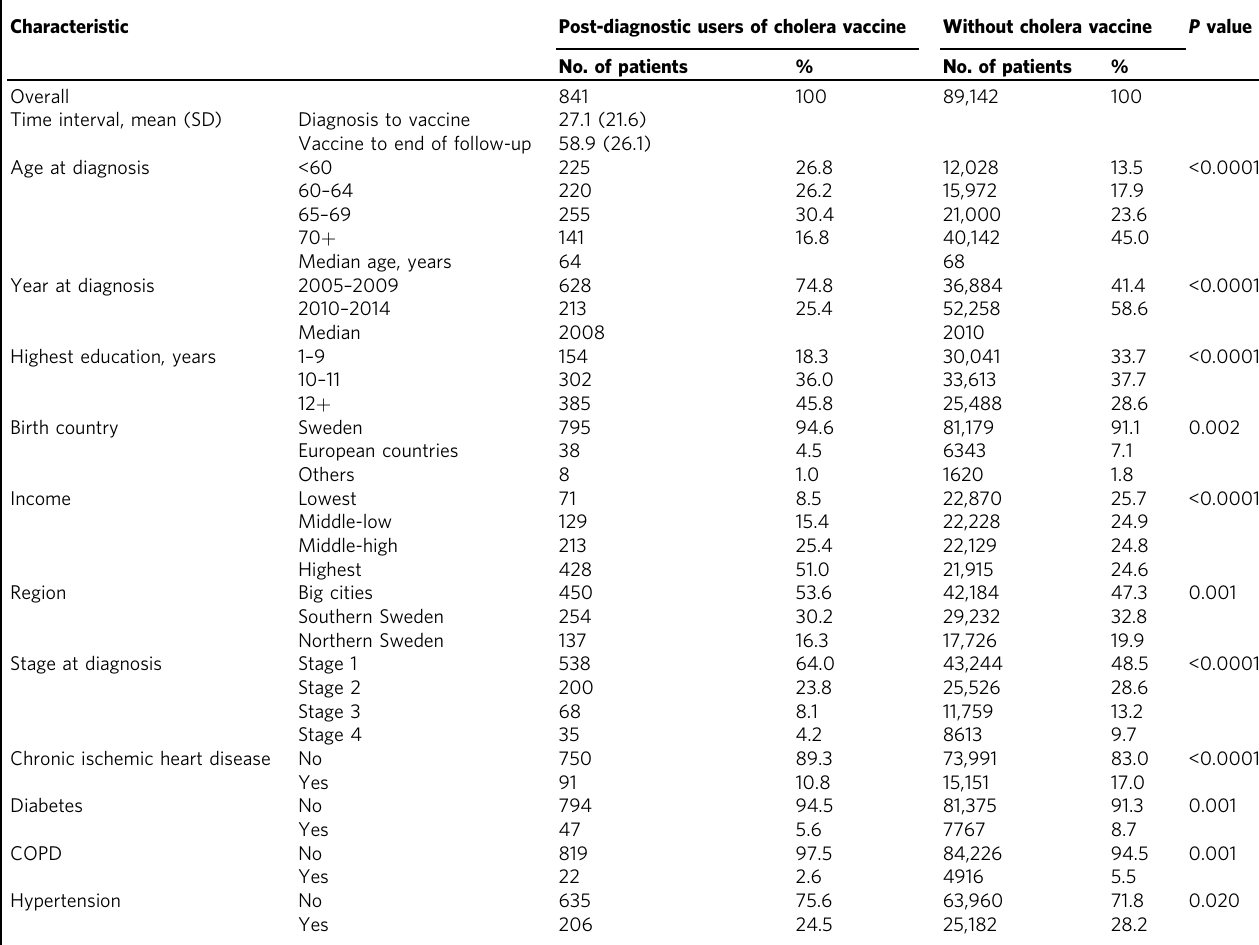
Table 1 Baseline demographic and clinical characteristics of patients with prostate cancer, strati fi ed by post-diagnostic use of cholera vaccine